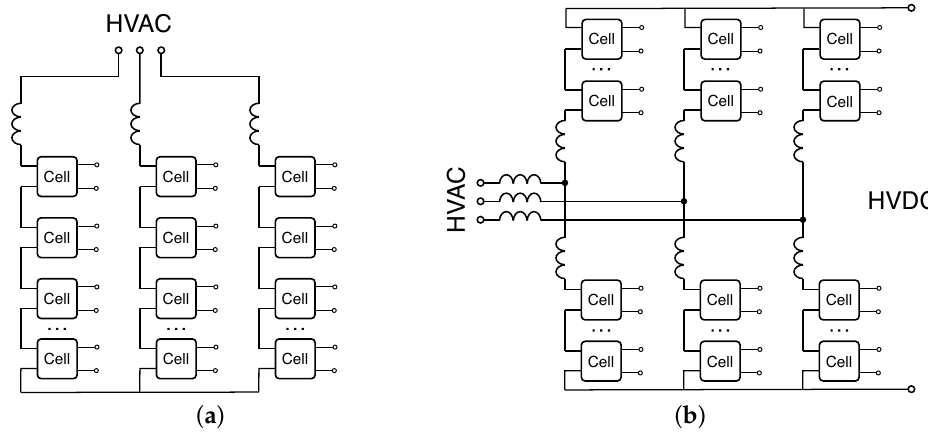
Figure 19. Examples of the most investigated AC/DC converter topologies (CHBC and MMC). ( a ) 3-phase CHBC, ( b ) 3-phase